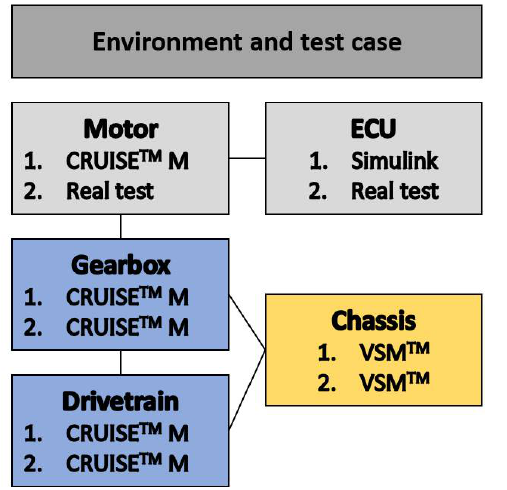
Figure 12. Topologies of virtual prototypes and different implementation levels .